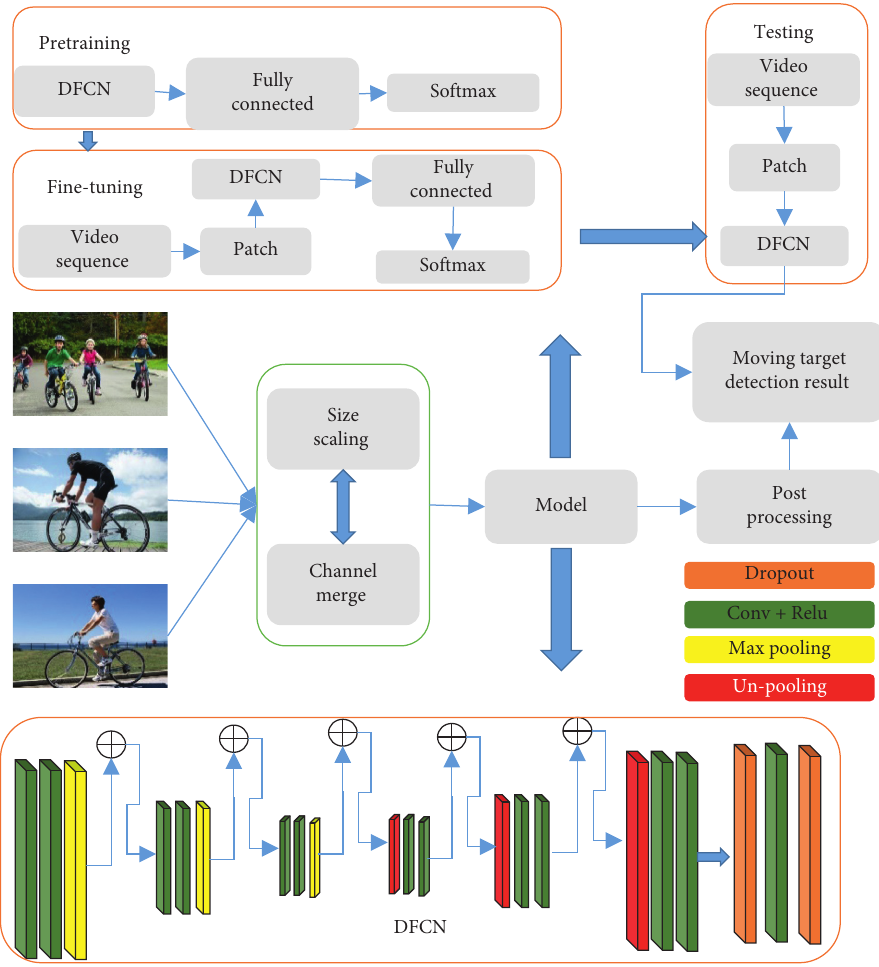
Figure 2: The overall framework of moving target detection for adaptive scenes.